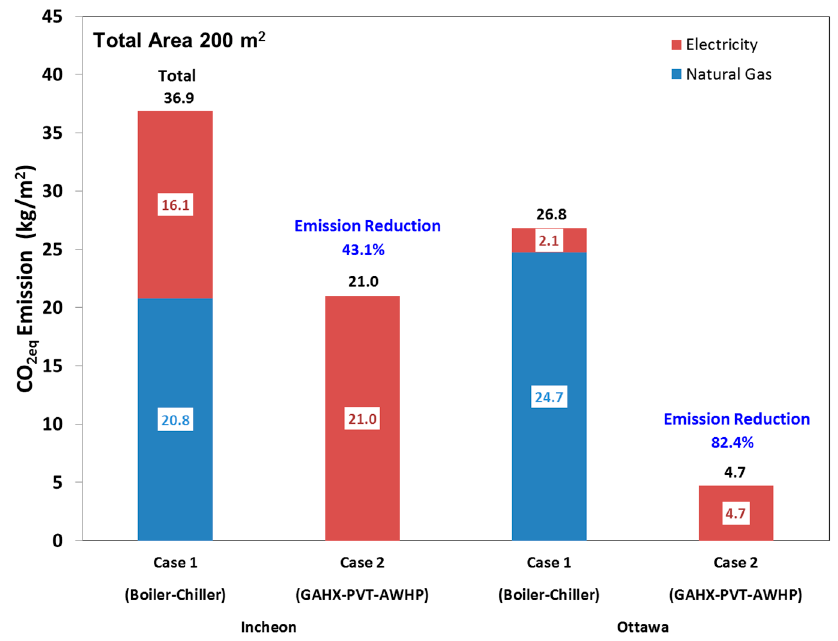
Figure 9. Annual CO 2 equivalent emission intensity.